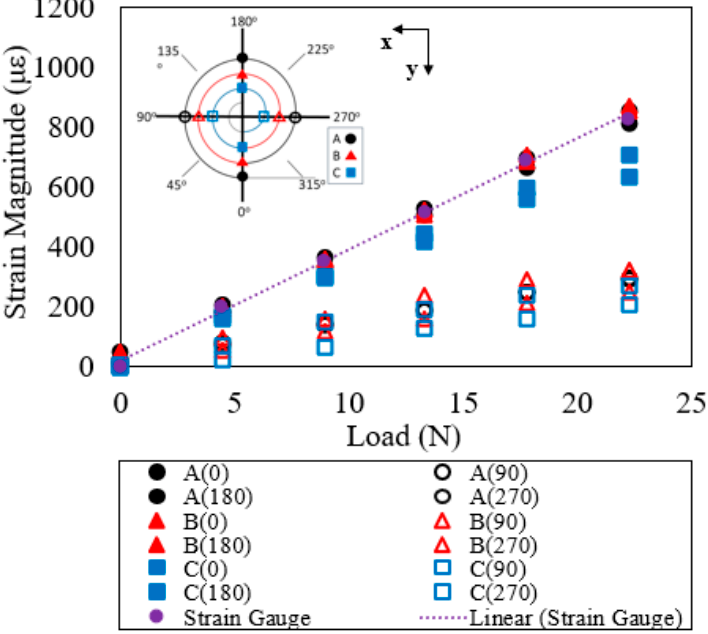
Figure 9. Absolute strain for regions A, B, and C within the spiral configuration.